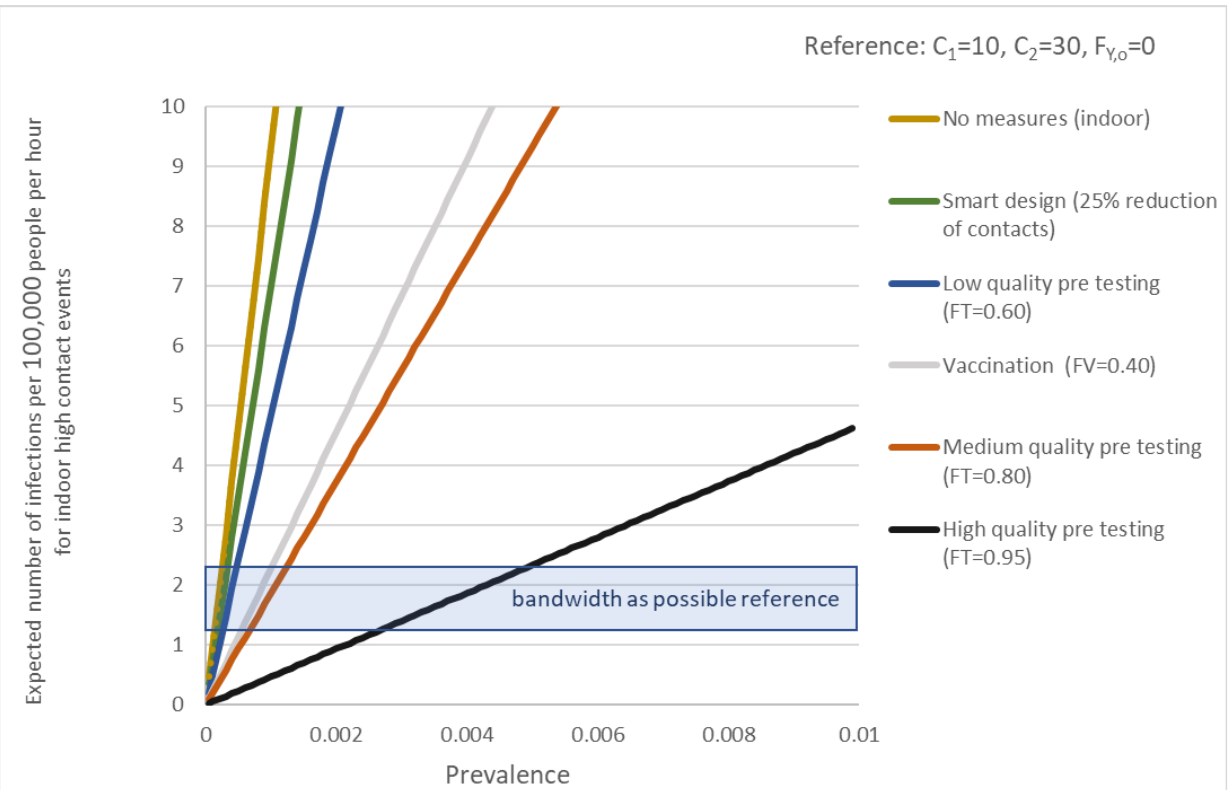
Figure 2. Risk of infections as a function of the prevalence for different packages of measures related to a possible reference.